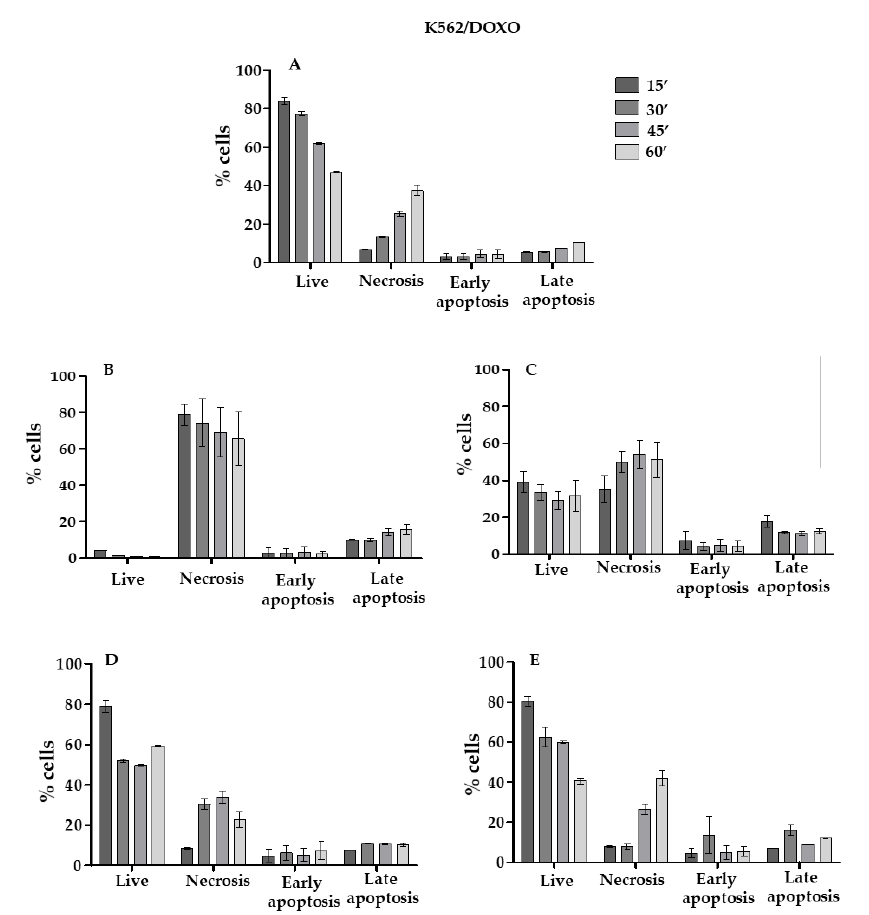
Figure 8. Effects of pump inhibitors (free or liposomal TAR and TPGS) on DOXO cytotoxicity in K562/DOXO cells. In particular, data are reported for DOXO ( A ), DOXO plus TAR ( B ), DOXO plus TAR-L( C ), DOXO plus TPGS ( D ), and DOXO+TPGS-L ( E ). Cytotoxic effects are expressed as the percentage of live, necrotic, and apoptotic cells detected in the samples incubated with DOXO in the presence and in the absence of the different pump inhibitors free and formulated.